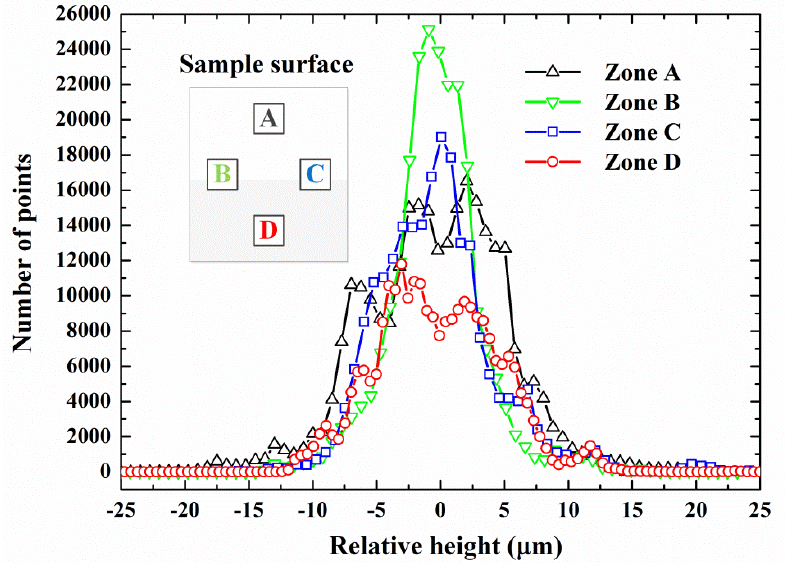
Figure 9. Statistical relation based on the morphological data (for comparison, a base plane where the relative height is predefined to be zero is identically set for the four